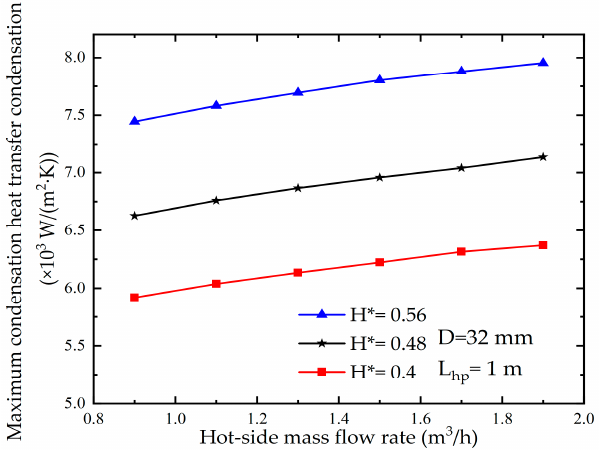
Figure 15. Comparison of maximum condensation heat transfer with different H ∗ . (The mass flow rate at cold side of the HPHEX is 2.9 m 3 /h.)